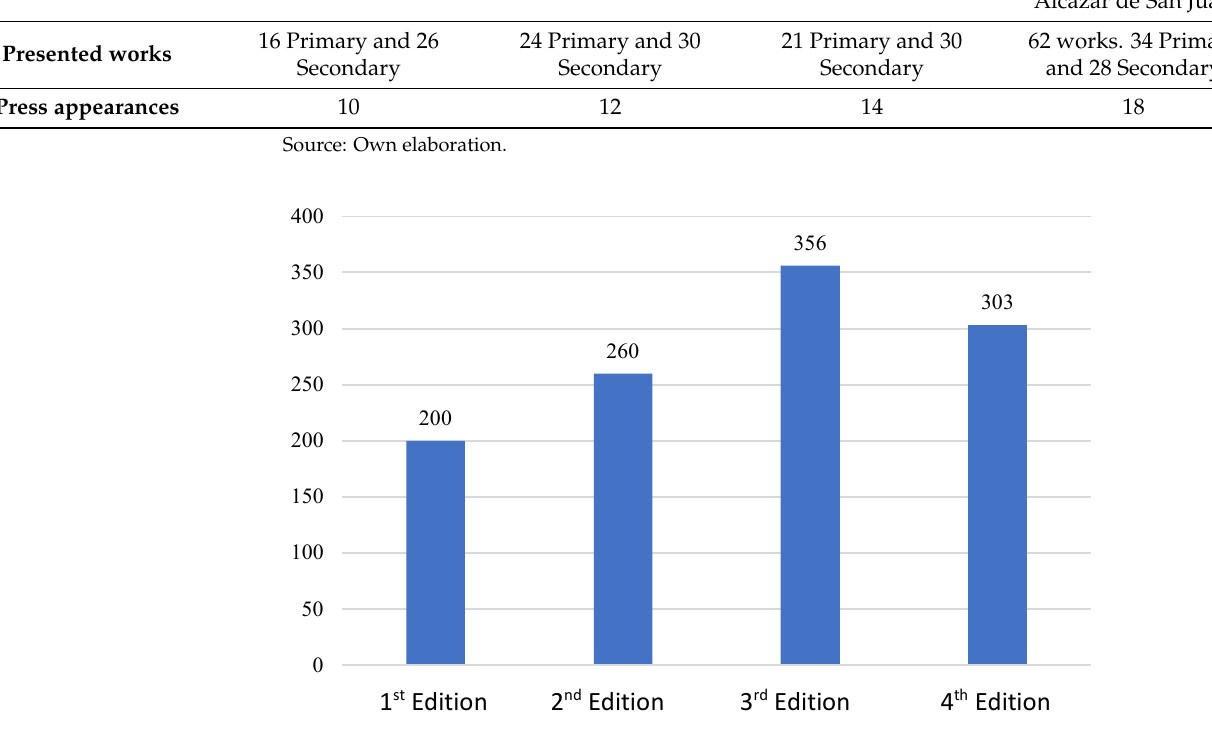
Figure 5. Evolution of participants per edition, Source: Own elaboration.